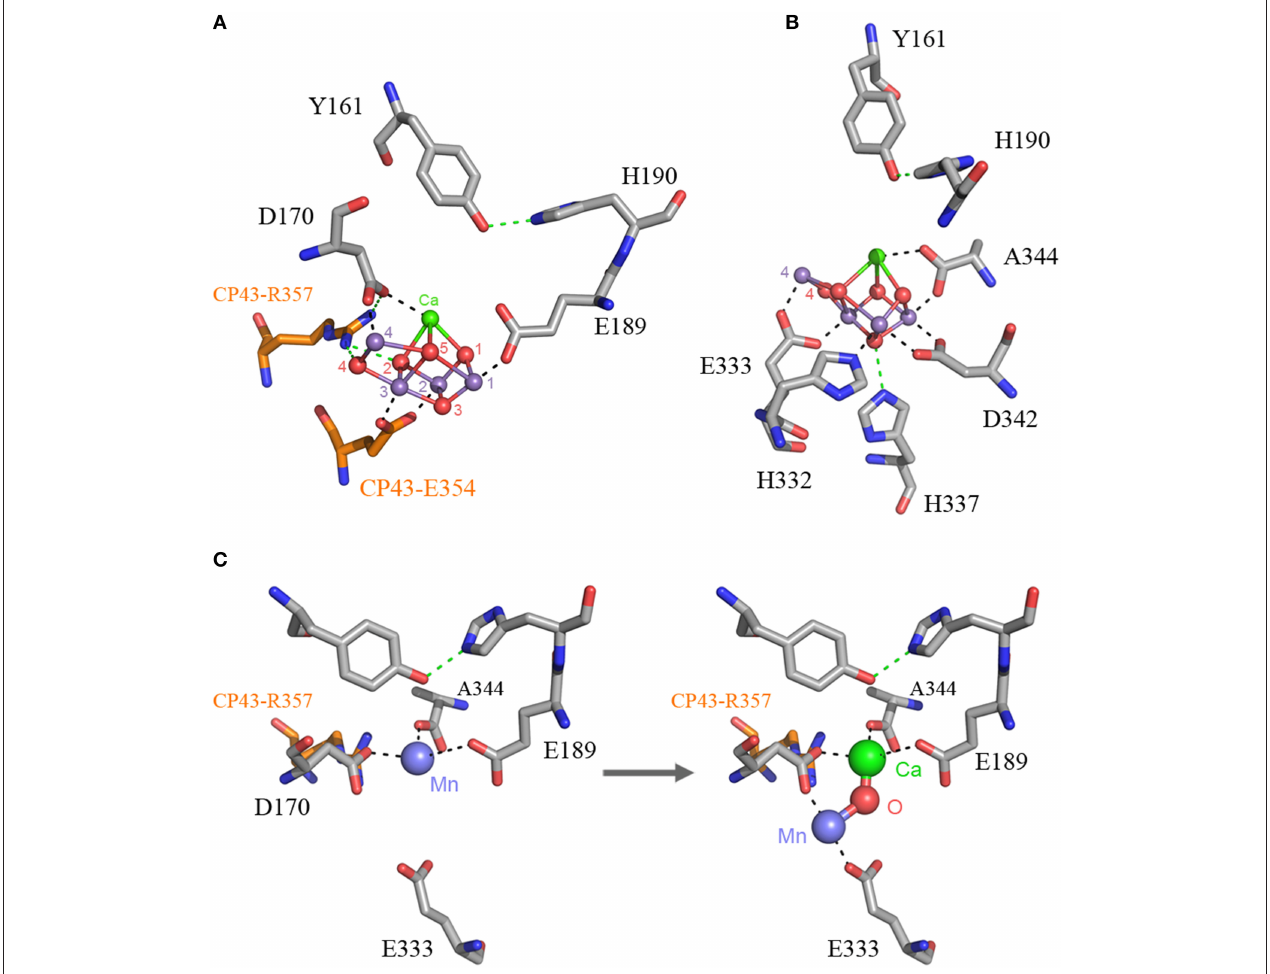
FIGURE 2 | The Mn 4 CaO 5 cluster of Photosystem II as resolved in the crystal structure by Umena et al. (2011), PDB ID: 3WU2. Panel (A) shows the cluster coordinated by the inner ligands D170 and E189 and the ligands provided by the CP43 subunit, E354, and R357. Panel (B) shows the ligands provided from the C-terminus of the D1 protein. Panel (C) shows a proposal for the high-affinity Mn binding site based on evolutionary grounds and supported by mutagenesis and spectroscopy (see text). After oxidation of the first Mn(II) to Mn(III), which might occur concomitantly with the deprotonation of a ligating water molecule, Ca 2 + binds. The binding of Ca 2 + shifts the initially bound Mn(III) to a position similar to that of Mn4 in the intact cluster.